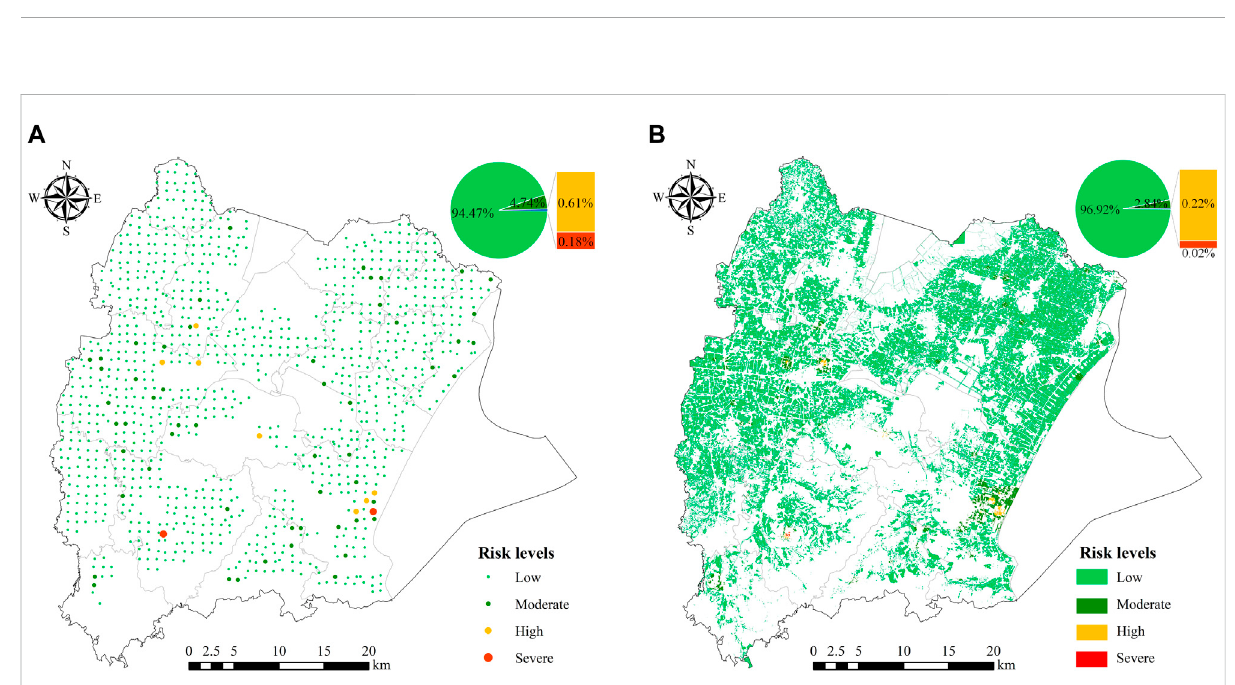
FIGURE 2 Distribution of potential ecological risk index evaluation results. (A) shows the evaluation results of the sampling sites. (B) shows the evaluation results of the cultivated land obtained by